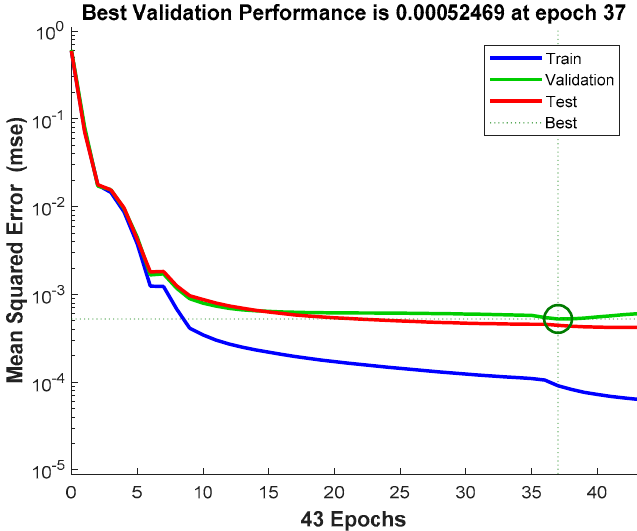
Figure 14. Plot of mean squared error in neural network training.